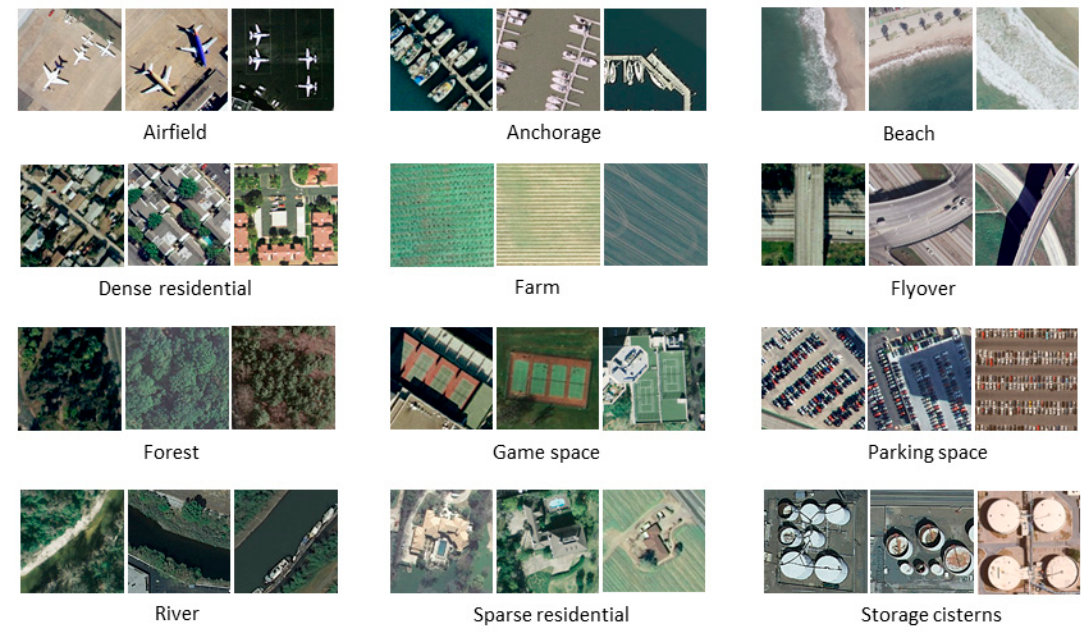
Figure 4. Example of images extracted from Merced dataset.